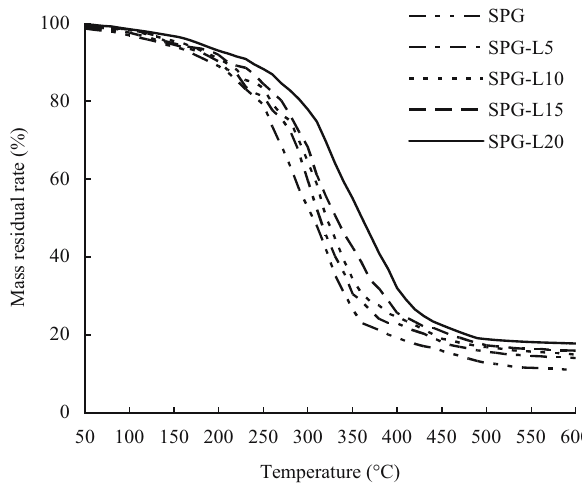
Figure 3: TGA analysis curves of composite fi lms.